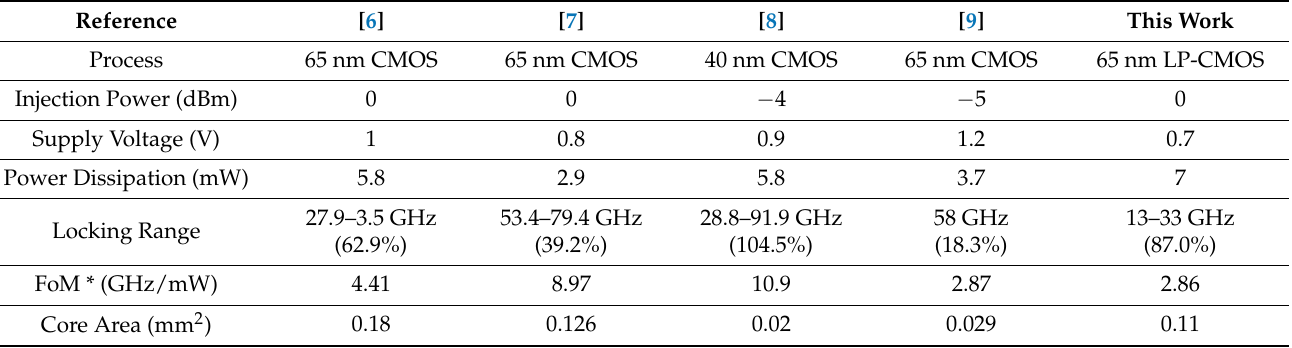
Table 2. Performance summary and